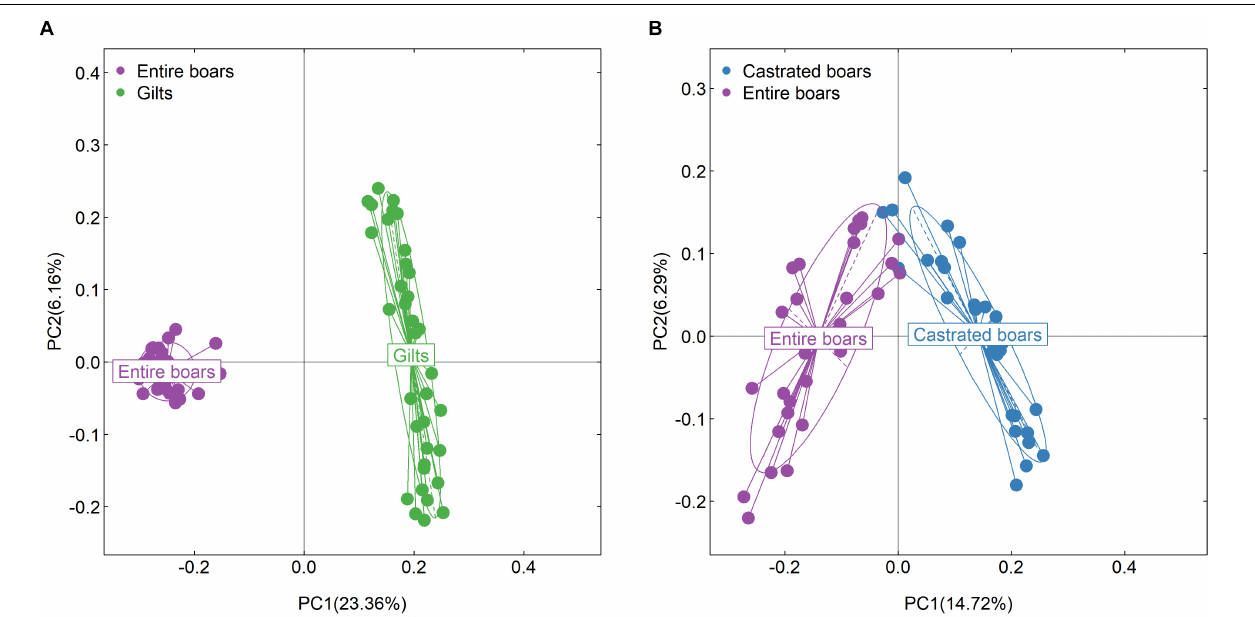
FIGURE 2 | Validation of the host gender effect on fecal microbial composition, and the shifts of boar fecal microbiota composition before and after castration in the F 6 cohort. (A) PCoA plot based on relative abundance of OTUs showing significant difference of gut microbial composition between entire boars and gilts in the F 6 population. (B) PCoA analysis indicates the significant difference of fecal microbial composition before and after castration. Each point represents the fecal microbiota of a